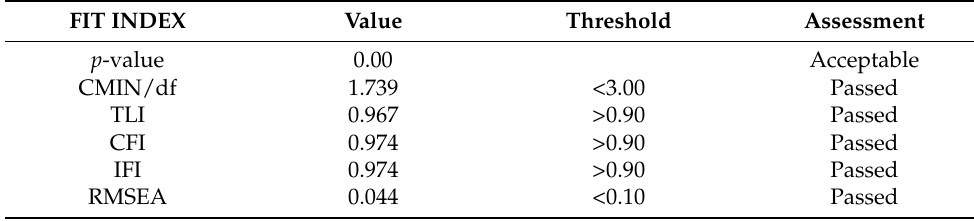
Table 8. The goodness of fit of the structural model (SEM).